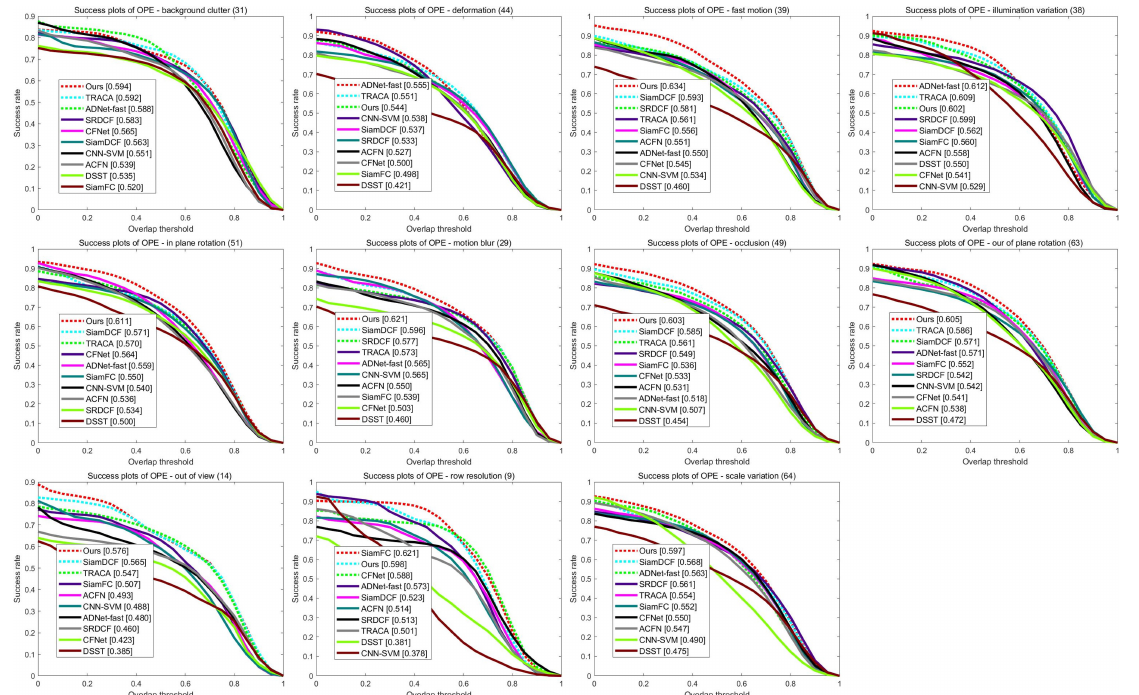
Figure 9. Comparison of success plots over 11 attributes.